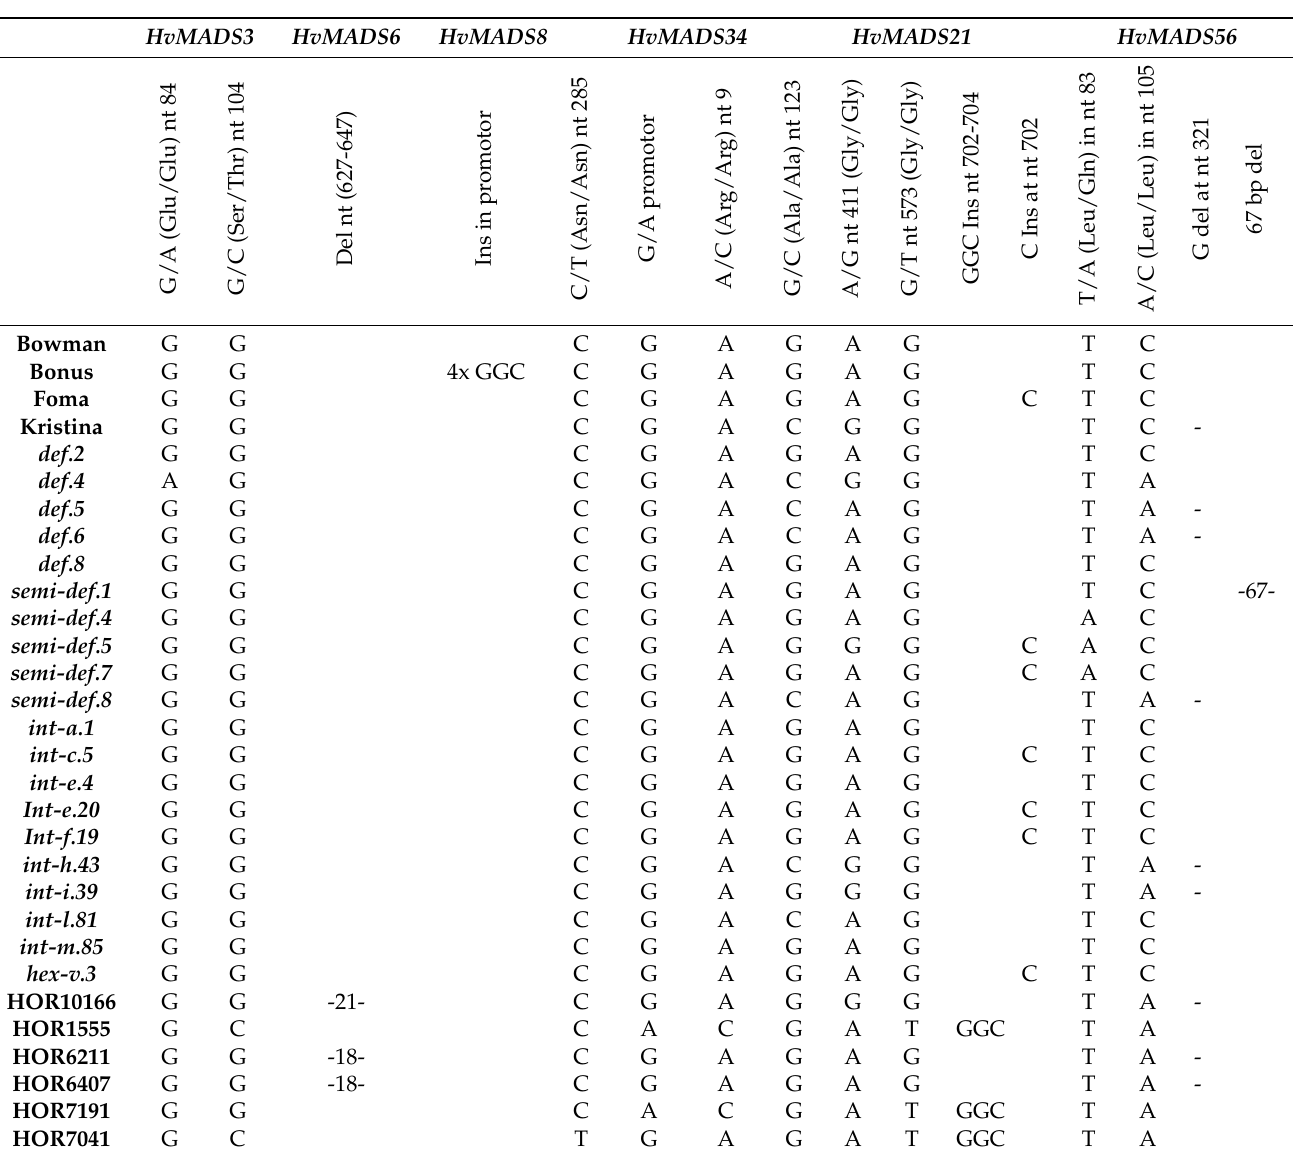
Table 2. Sequence variations and polymorphism at Hv-MADS3, Hv-MADS6, HvMADS8, HvMADS34, HvMADS21 and HvMADS56, including the nucleotide (nt) position of each among the tested lines.